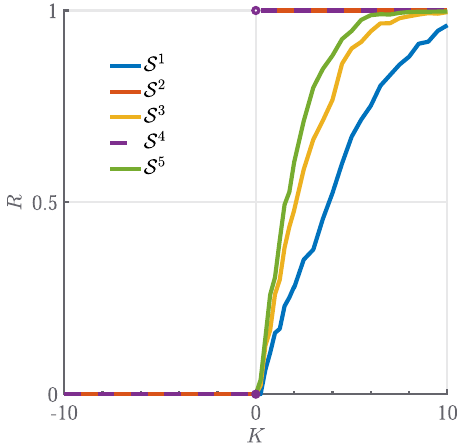
Fig. 6 The transition from incoherence to synchronization depends on the parity (odd/even) of the dimension n of the n -sphere S n . The order parameter R is given by Eq. (15). The uniform coupling parameters k ij = K between agent i and j range from negative, where R = 0 indicates incoherence, to positive, where R = 1 indicates synchronization. We take the average value of R from M = 10 3 system evolutions per point. We use N = 100 agents. To fi nd the discontinuous phase transition for small K values we have chosen a large fi nal time T =